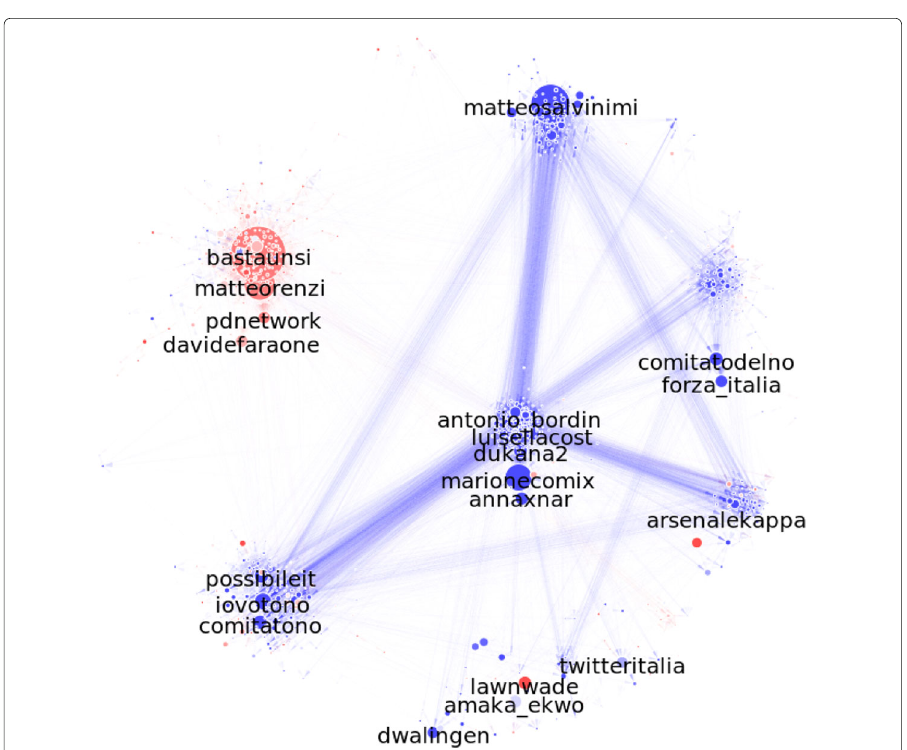
Fig. 2 The top 1000 vertices of the whole graph by pagerank. Vertex size is by pagerank, vertex and edge color is by polarization (YES=red, NO=blue), the 20 top users are